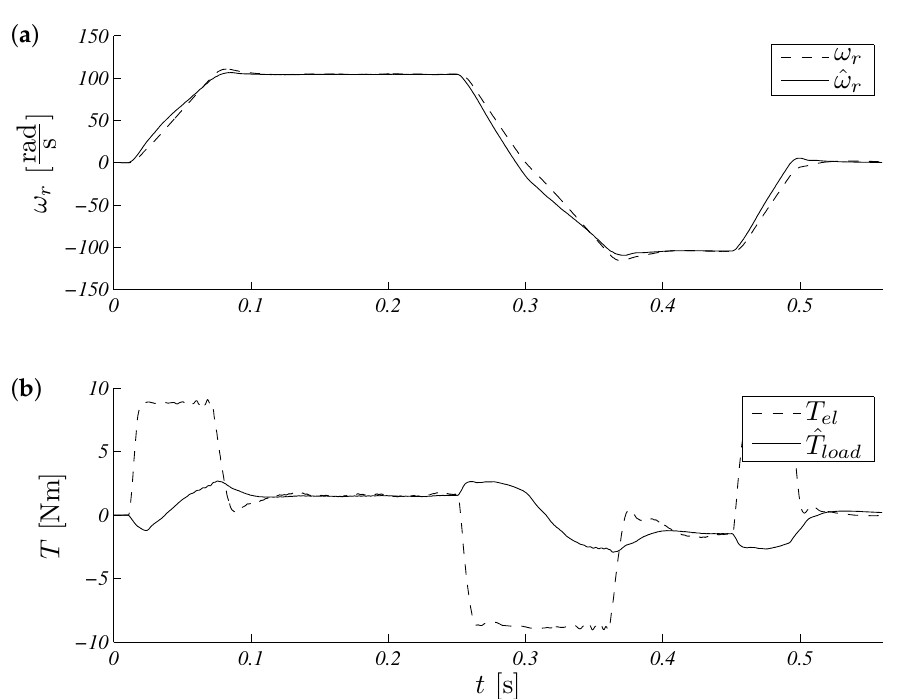
Figure 5. Unscented Kalman filter speed ( a ) and torque ( b ) response for reference speed ω ∗ r = 104.72 rad